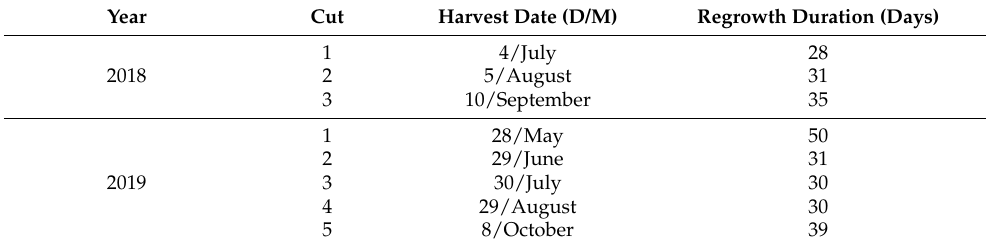
Table 1. Harvest date and the during of each cut for 2018 and